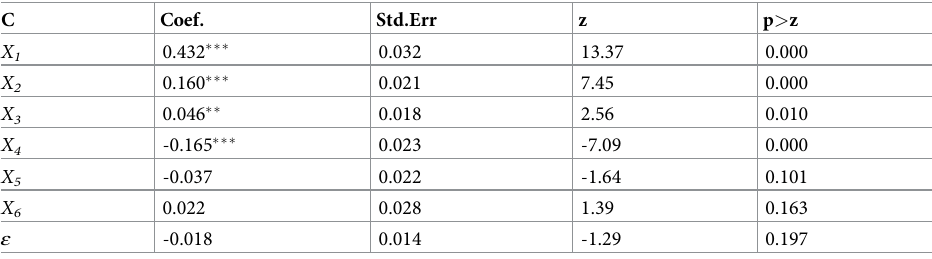
Table 4. Results of the regression